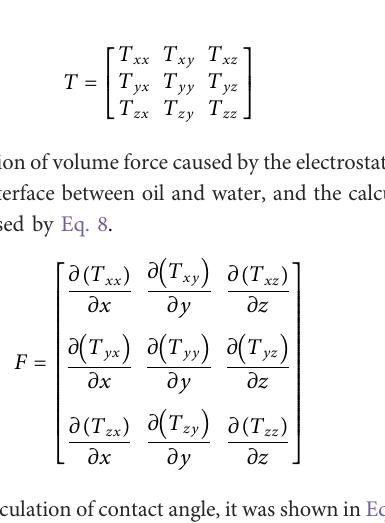
FIGURE 4 Evolution of the aperture ratio of arc multi-electrode and single-electrode in the pixel opening stage. The aperture ratio curves were obtained at a voltage of 20 V. Each curve consisted of 65 data points with an interval of 0.1